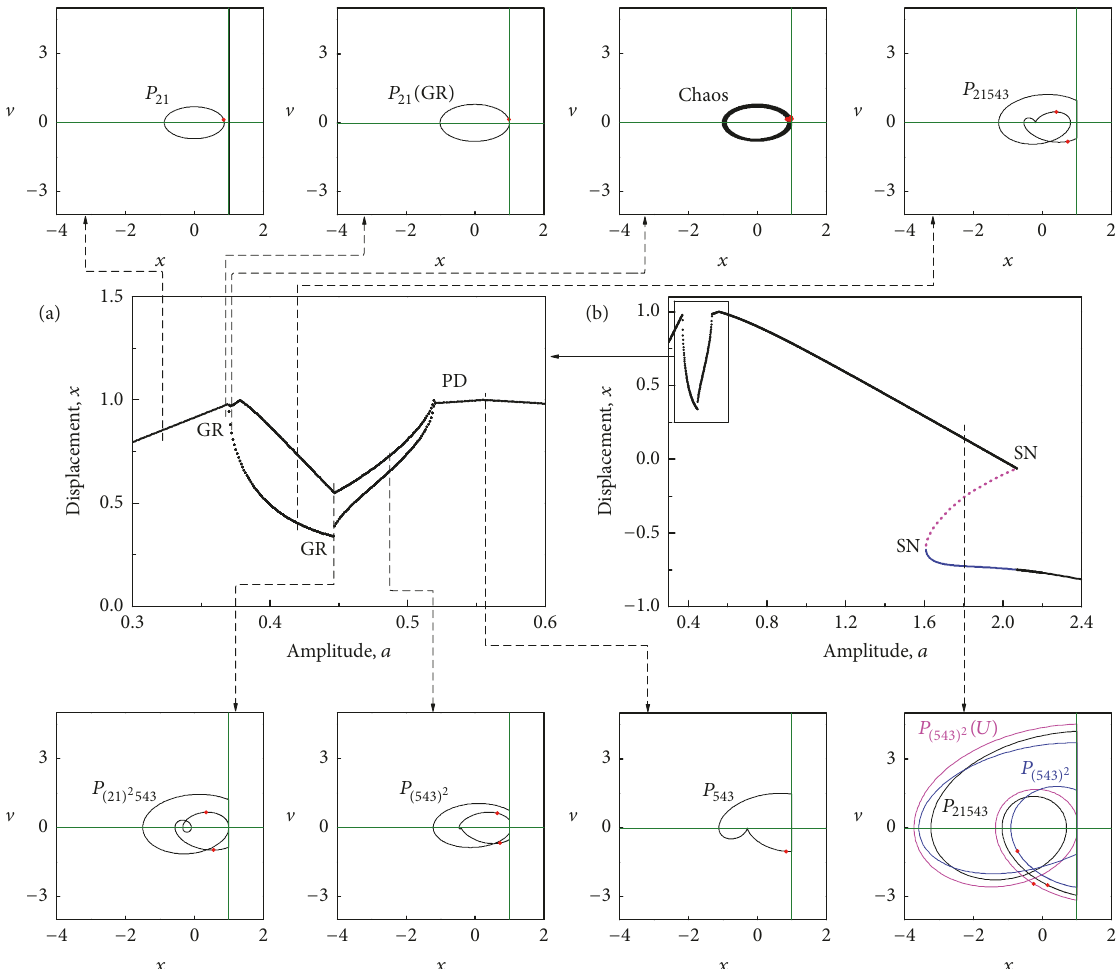
Figure 5: Bifurcation diagrams constructed for the mass displacement under varying forcing amplitude (a) 𝑎 ∈ [0.3, 0.6] and (b) 𝑎 ∈ [0.6, 2.4] calculated at 𝜔 = 0.8 , 𝑒 = 1 , 𝜉 1 = 0.05 , 𝜉 2 = 0.04 , and 𝑟 = 0.7 . Black and blue dots show the mass displacements swept in increasing and decreasing directions, respectively. The magenta dots show the unstable period-1 orbit with one impact. Additional windows demonstrate the trajectories of the attractors on the phase plane (𝑥, V ) obtained for 𝑎 = 0.32 , 𝑎 = 0.36981 , 𝑎 = 0.36991 , 𝑎 = 0.42007 , 𝑎 = 0.44681 , 𝑎 = 0.48486 , 𝑎 = 0.55328 , and 𝑎 = 1.8 , respectively. Stable period-1 orbit with two impacts per period, unstable period-1 orbit with two impacts per period, and stable period-1 orbit with one impact per period are shown in blue, magenta, and black. Green lines indicate the location of the discontinuity boundaries 𝑥 = 𝑒 and V = 0 , and the red points show the Poincar´e